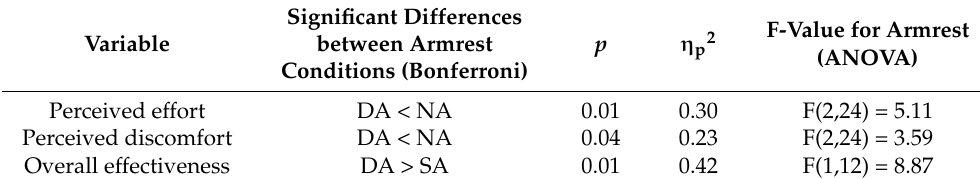
Table 7. Summary of statistically significant main effects and interactions ( p < 0.05) for the questionnaire results between armrests (DA = dynamic armrest, SA = stationary armrest, and NA = no armrest).